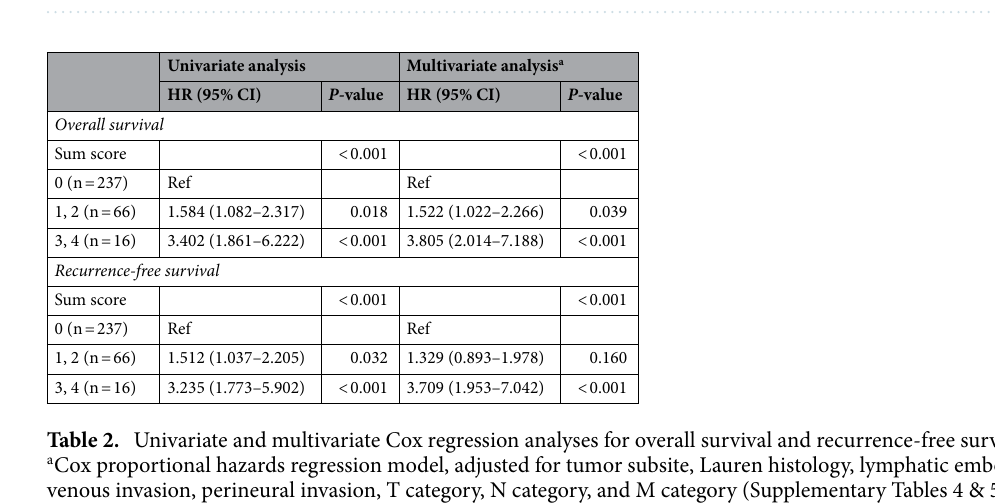
Figure 1. Survival curves for gastric cancer patients according to the sum score from 0 to 4 ( a , b ) and three subsets of gastric cancer patients according to the sum score, 0, 1–2, or 3–4 ( c , d ). ( a , c ) overall survival and ( b , d ) recurrence-free survival.